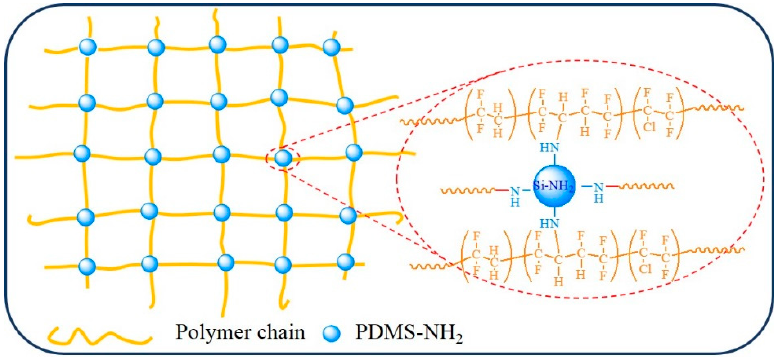
Figure 1. Schematic illustration for the chemical structure of the hybrid.